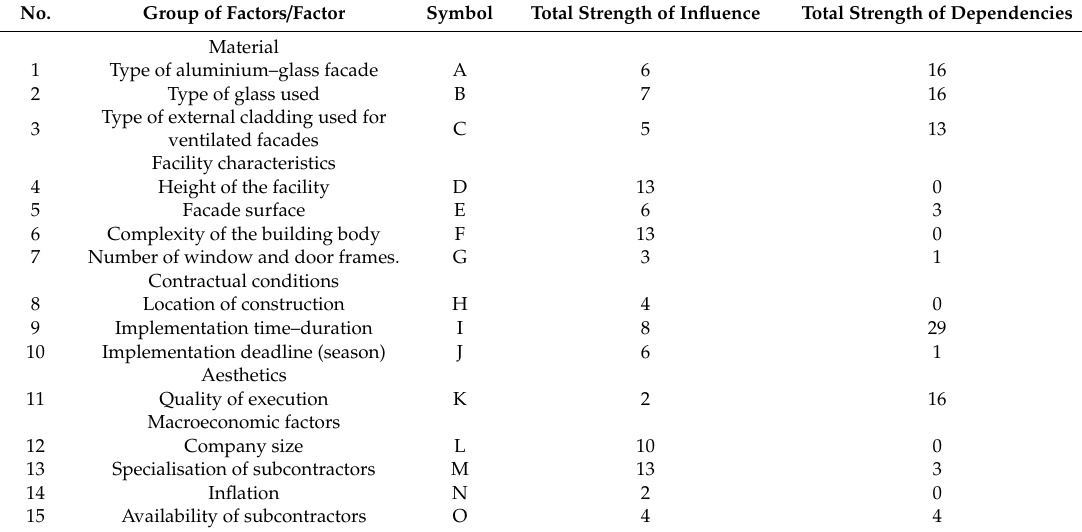
Table 2. Power of influence and dependence on identified